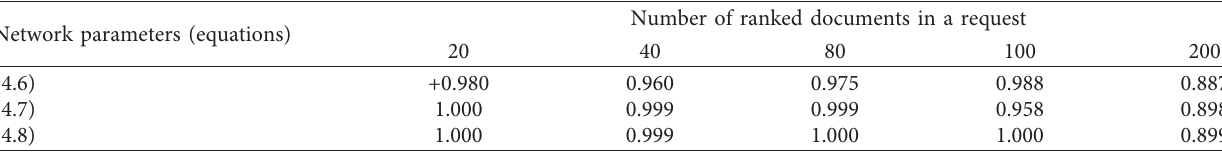
Table 2: Results of the experimental evaluation of the quality of the solution of the vector ranking problem with the number of ranked links from 20 to